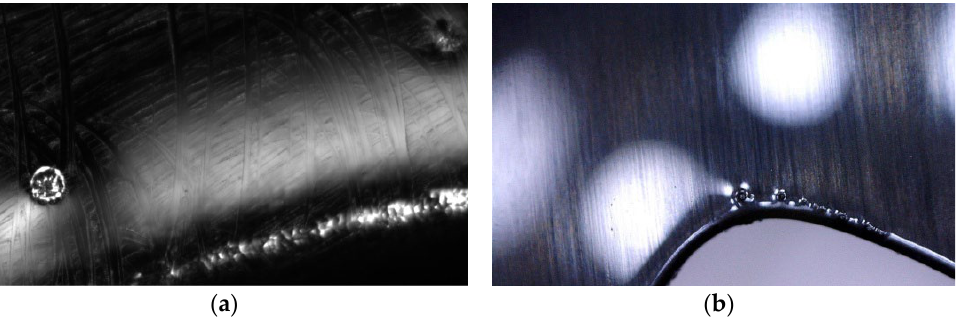
Figure 11. Laser engraving of the parts. Figure 12. The issue (fish-eye) detected on the final clear coated parts: ( a ) in the area of the square windows; ( b ) at a distance from their edge.